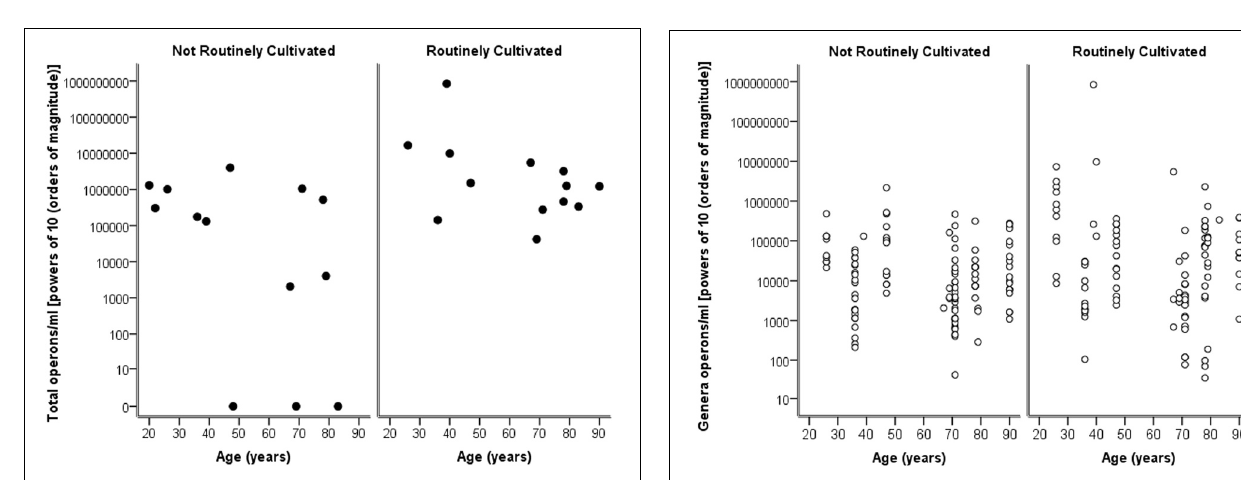
FIGURE 4 | A plot of the genus specific count (operons/ml) on a logarithmic base ten scale against age for routinely cultivated and not routinely cultivated bacteria (including those not individually identified in routine